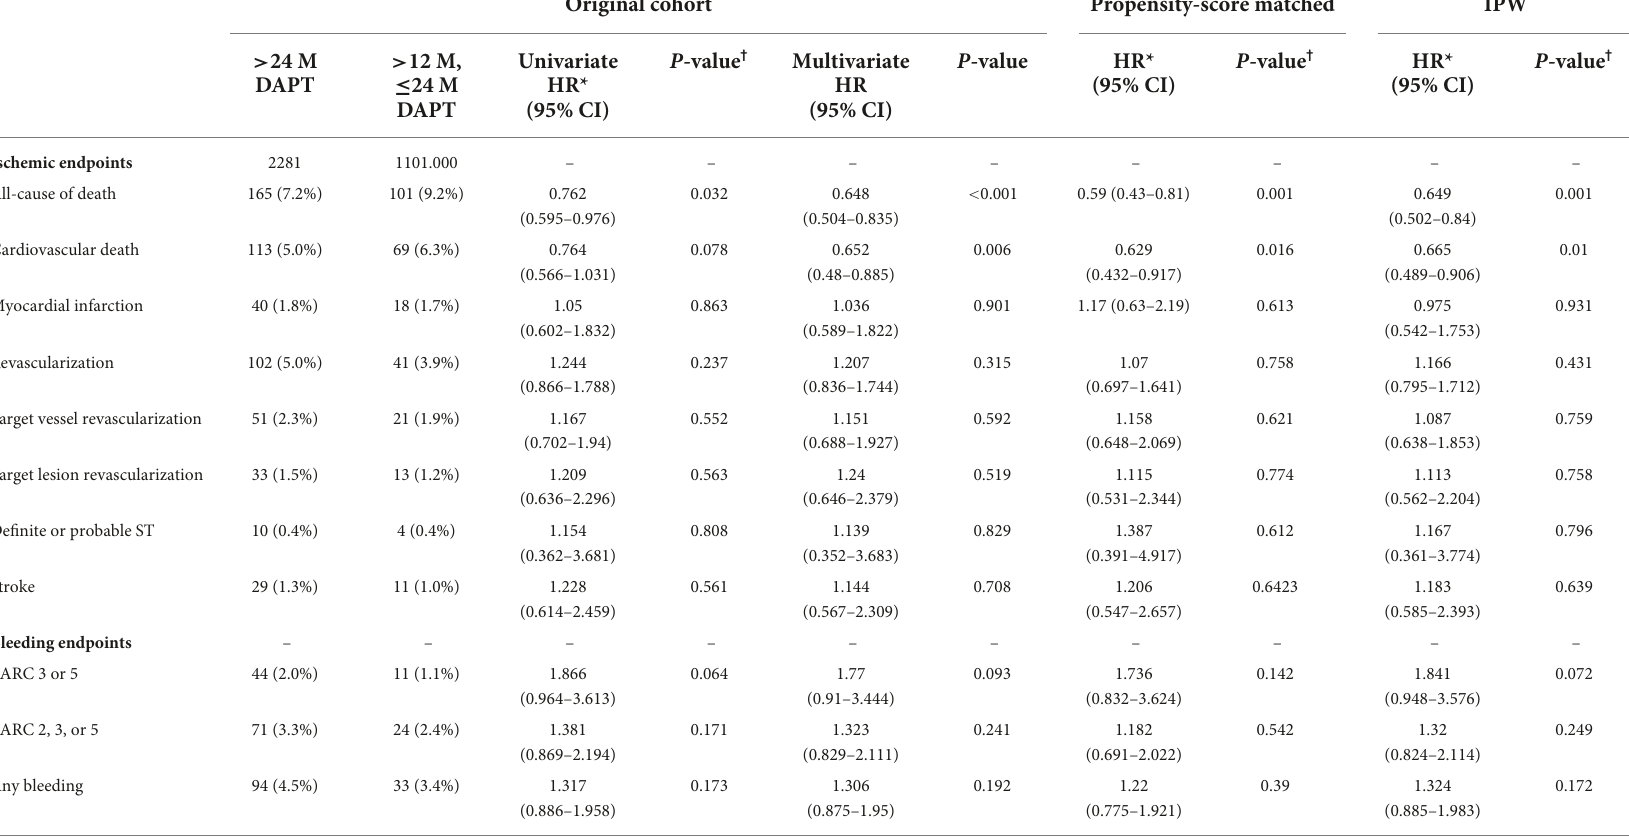
TABLE 2 Ischemic and bleeding outcomes in acute myocardial infarction (AMI) patients with the PEGASUS-TIMI 54 criteria according to the dual antiplatelet therapy (DAPT) duration. Original cohort Propensity-score